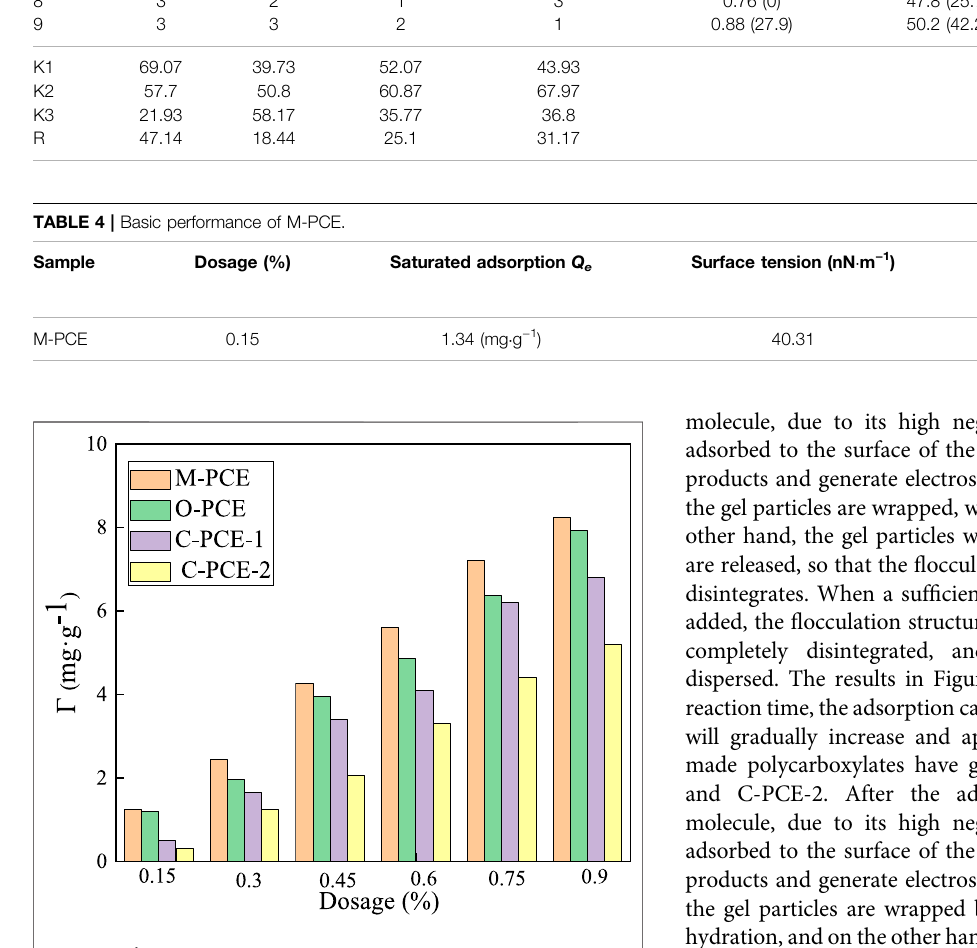
Frontiers in Materials |